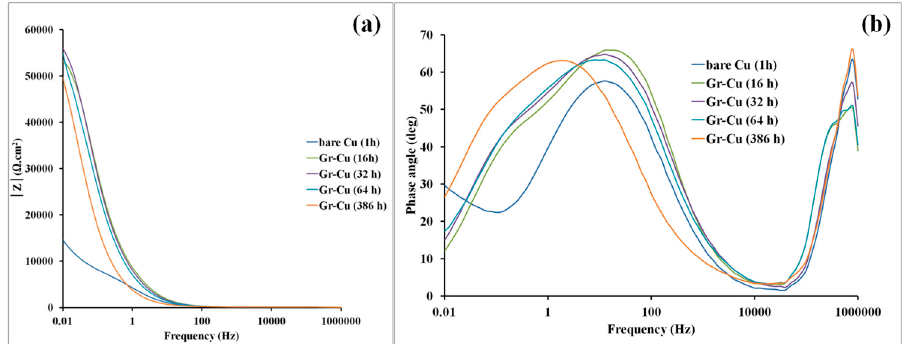
Figure 4. ( a ) Bode modulus and ( b ) Bode phase plots for bare and graphene coated copper (Gr-Cu) after immersion for different durations (16–386 h) in 0.1 M NaCl (Note: bare Cu was immersed only for 1 h).